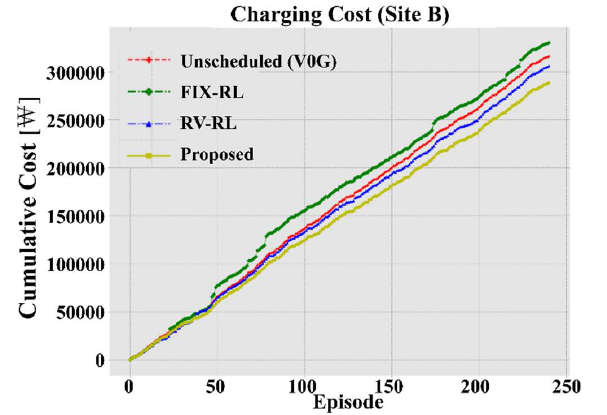
387 Figure 9. Cumulative charging cost of the proposed method and the benchmarks for site B. Table 1. Cumulative charging cost over total test period in numeric form. 389